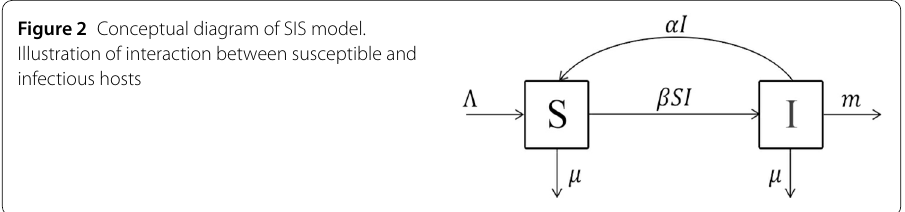
Table 1 Parameters and their biological meanings Parameter Biological meaning Λ Host recruitment rate β Host-to-host transmission rate 1/ α Infectious period μ Host settlement rate m Disease-induced death rate